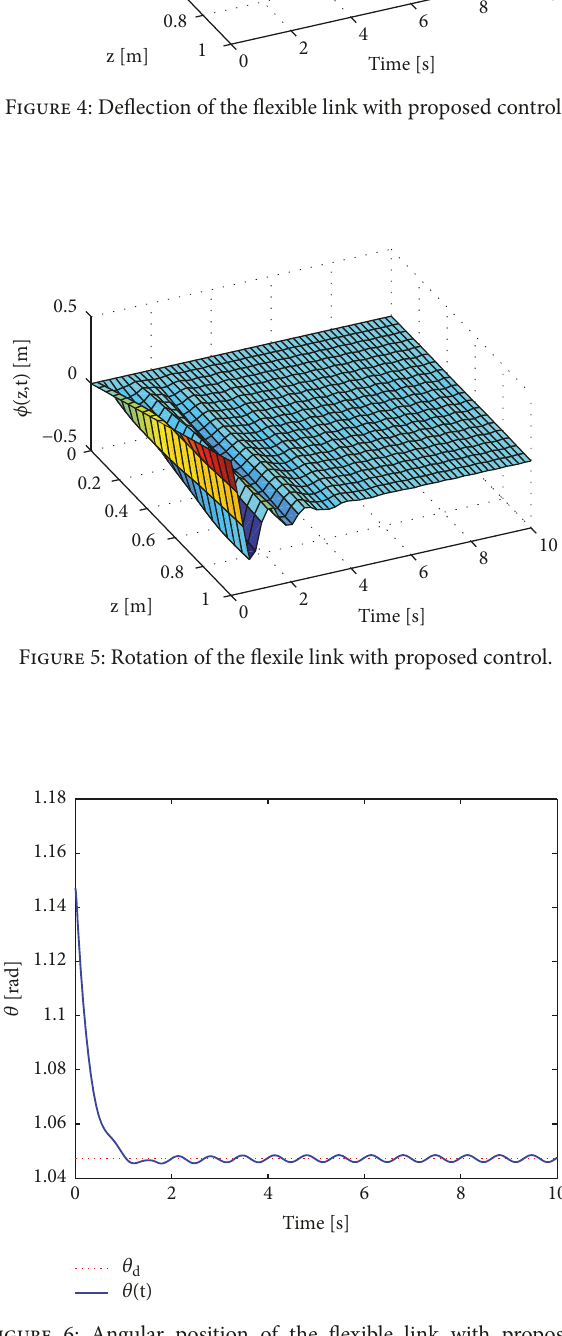
Figure 6: Angular position of the flexible link with proposed control.